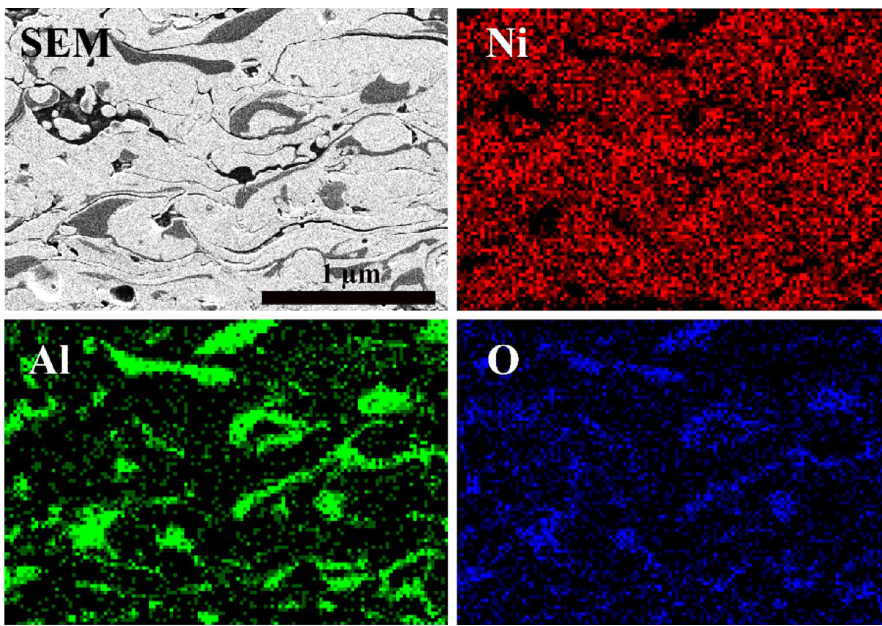
Fig. 4 SEM images of the cross-section ( a – c ) and surface ( d – f ) of the Ni–Al solar absorber with the three different thicknesses Fig. 5 SEM and EDX